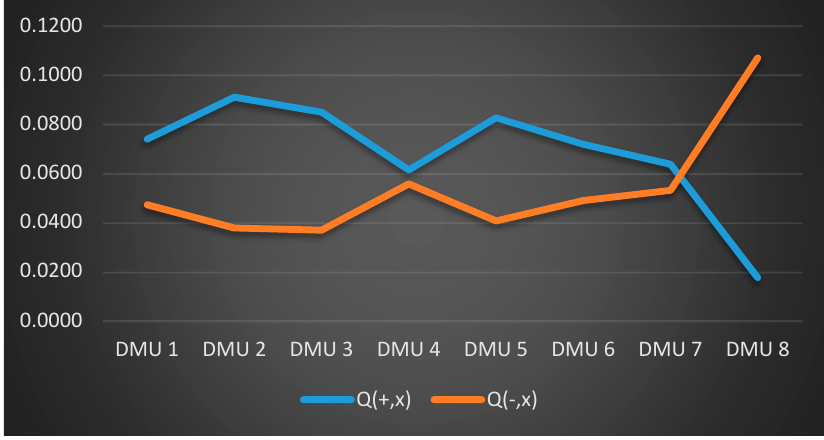
Figure 8. Geometric distance from positive ideal solution (PIS) and negative ideal solution (NIS).